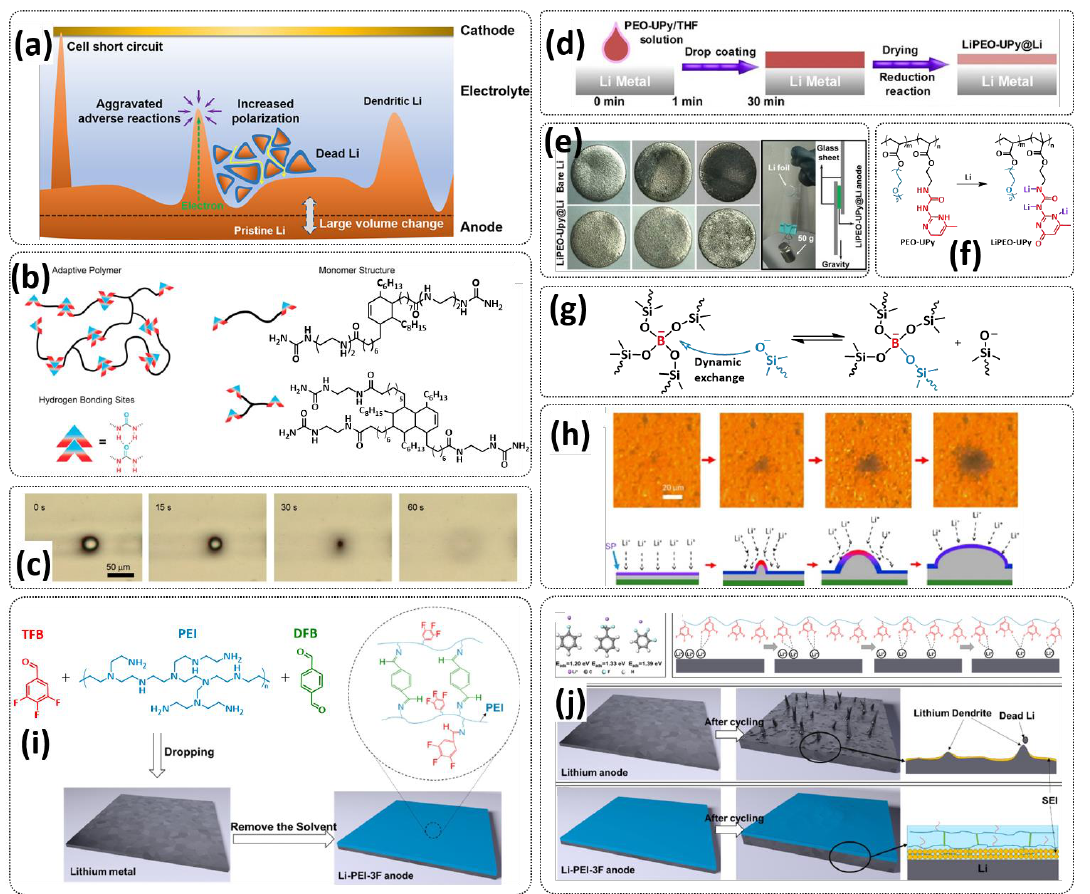
Figure 18. ( a ) Scheme of dilemma for Li-metal anode in rechargeable batteries. Reproduced with permission from [166]. Copyright © 2017, American Chemical Society. ( b ) Chemical structure of the SHP. The black lines are the fatty acid backbone, and the red–blue boxes are the urea hydrogen-bonding sites. The right-hand side shows the molecular structure of the diacid and triacid backbones. ( c ) Opti- cal microscope images showing the flowability of the polymer coating via the healing process of an artificially created pinhole. Reproduced with permission from [152]. Copyright © 2016, American Chemical Society. ( d ) Schematic diagram of PEO–UPy coating on Li-metal surface. ( e ) Photographs of bare Li and LiPEO–UPy@Li anodes exposed to ambient air for different durations ( left ) and adhesion test of PEO–UPy@Li anode against 50 g mass ( right ). ( f ) Chemical structures of the PEO-UPy and LiPEO-UPy polymers. Reproduced with permission from [155]. Copyright © 2020 Wiley-VCH Verlag GmbH & Co. KGaA, Weinheim. ( g ) Schematic diagrams showing the design of the SP-modified Li anode. ( h ) Series of optical microscope images depicting the Li-metal deposition process on SP-coated Cu. Scale bar: 20 µ m. ( above ) Schematic of Li deposited on SP-coated Cu. The red color in the SP coating represents the local dynamic stiffening. ( bottom ) Reproduced with permission from [130]. Copyright © 2017, American Chemical Society. ( i ) Schematic diagrams of the preparation of the PEI-3F interlayer on a Li-metal anode. ( j ) Theoretical calculations on the adsorption binding energies between lithium ions and the F-containing groups; Schematic diagram of the influence of the molecular motion of the grafted F groups on the distribution of Li + at the electrolyte/electrode interface. Li-deposition process on the bare Li ( up ) and Li-PEI-3F anodes ( bottom ). Reproduced with permission from [156]. Copyright © 2021, American Chemical